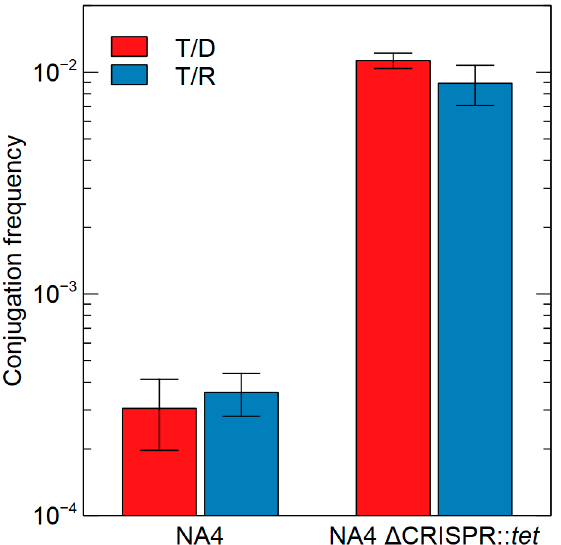
Figure 6. Conjugation frequency of pJB3kan1_Rmet2825 (containing one spacer identified in the NA4 CRISP-Cas system) from donor E. coli MFDpir to recipient C. metallidurans NA4 and NA4 ∆ CRISPR:: tet , respectively. Median values plus corresponding calculated standard deviations across biological triplicates are shown (T/D = conjugation frequency per donor; T/R = conjugation frequency per recipient).